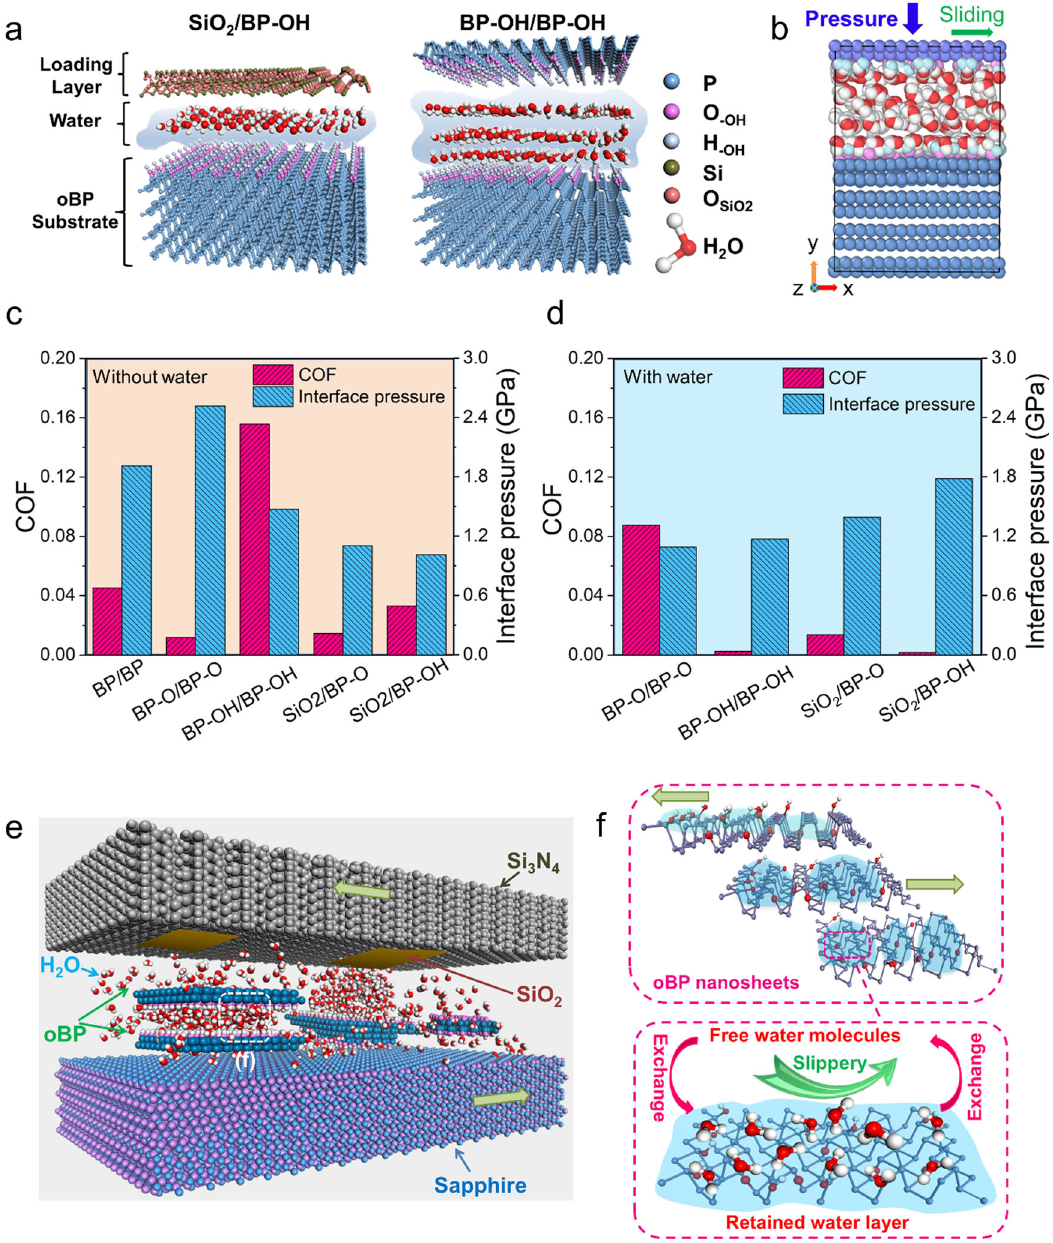
Fig. 6 Molecular dynamics (MD) simulations of the sliding processes at the SiO 2 /oBP and oBP/oBP interfaces. a Modeled structures of the SiO 2 /oBP and oBP/oBP systems. b Typical simulated LAMMPS model. Variations of the interface pressures and COFs under an applied pressure of 1 GPa pressure and a speed of 1 m/s without ( c ) and with ( d ) water molecules involved at the friction interface. Five groups at the friction interface, including BP/BP, BP-O/BP-O, BP-OH/BP-OH, SiO 2 /BP-O, and SiO 2 /BP-OH, have been studied. For water involved at the friction interfaces, the single-layer water molecules are fi lled for SiO 2 /BP-O and SiO 2 /BP-OH, and three-layer water molecules are fi lled for